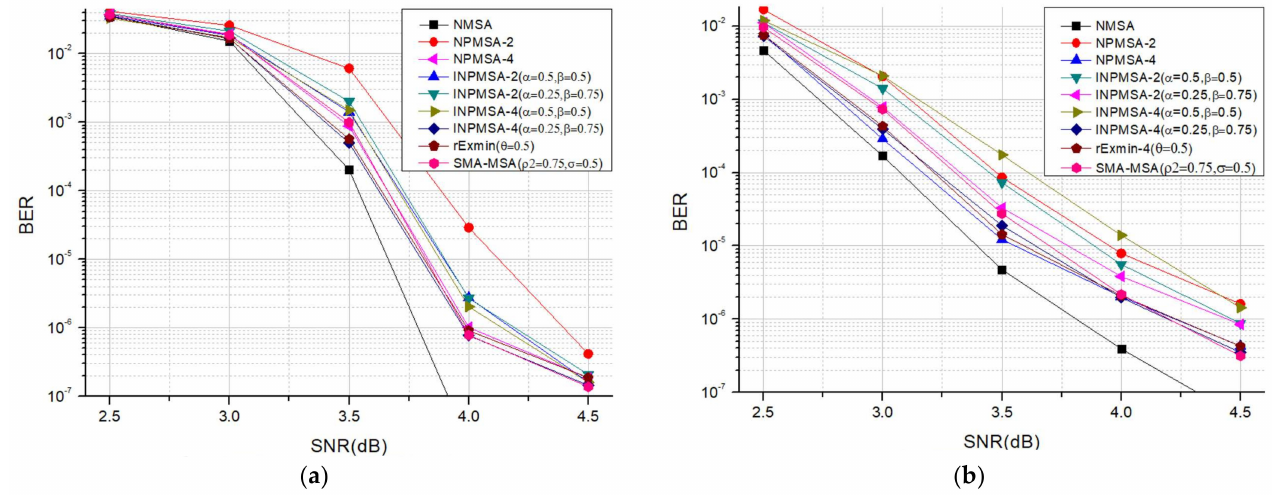
Figure 5. Simulation results of different algorithms in 5G NR ( a ) rate-11/13 BG 1 and ( b ) rate-5/7 BG